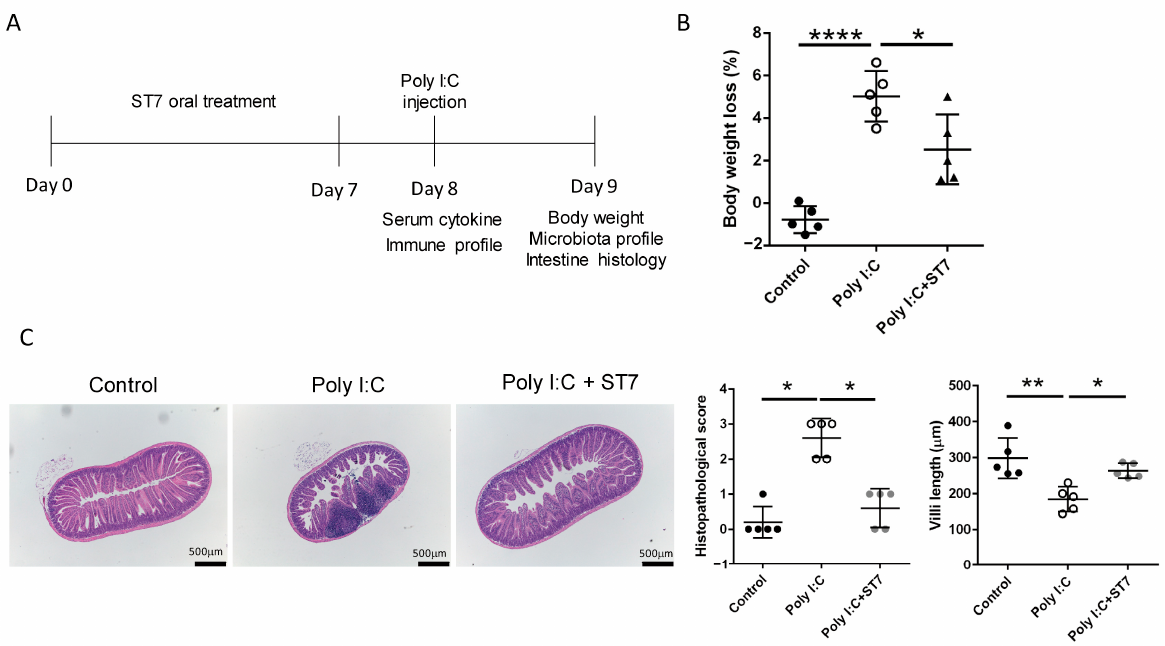
Figure 1. Streptococcus thermophilus strain 7 (ST7) treatment prevents small intestine injury